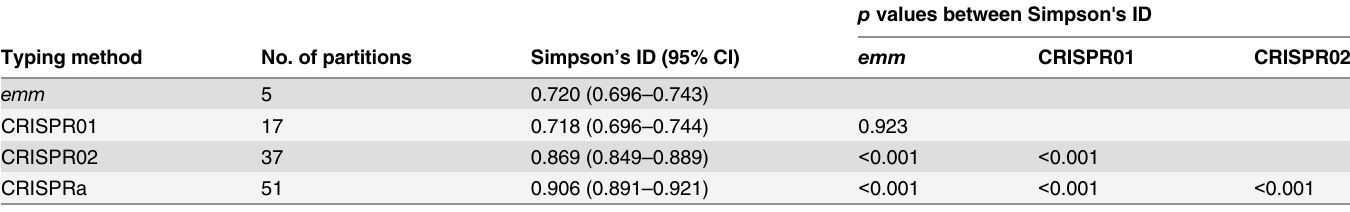
Table 3. Simpson ’ s index of diversity (ID) of emm , CRISPRa, CRISPR01, and CRISPR02